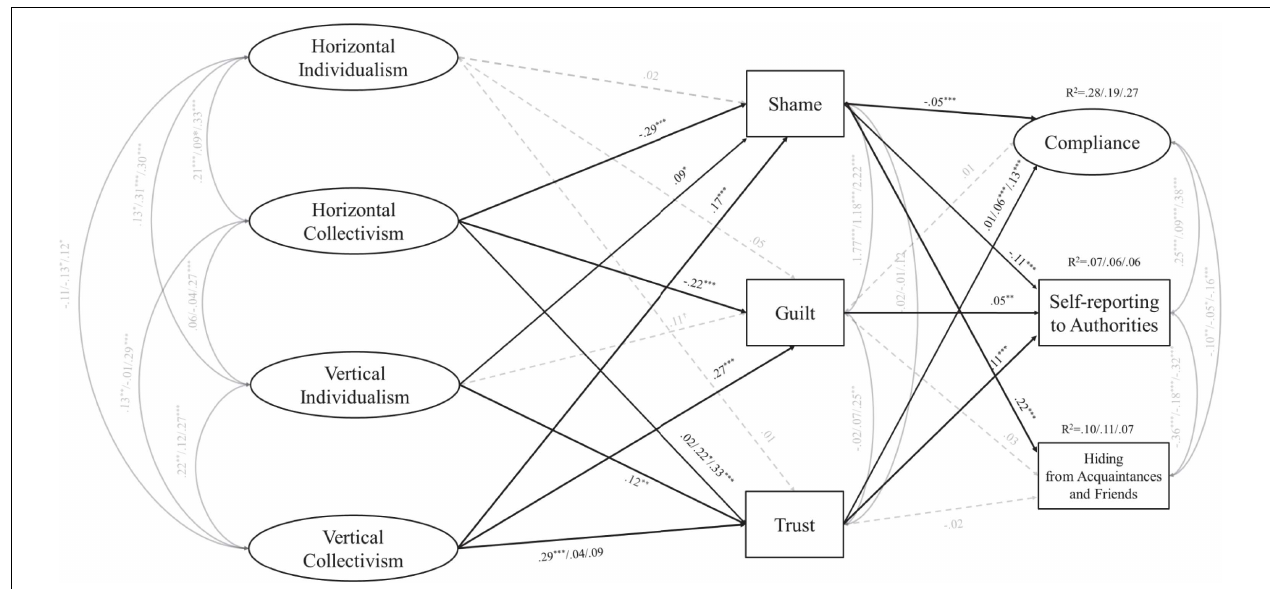
FIGURE 1 | Structural equation model showing unstandardized coefficients. Multiple coefficients indicate an unconstrained path and are reported as USA/IT/KOR. Dashed lines are non-significant paths. Gender, age, perceived concern, and political orientation are covariates in the model. *** p < 0.001, ** p < 0.01, * p < 0.05, ‡ < 0.10. TABLE 3 | Within groups completely standardized solutions for coefficients in the study. United States Italy South Korea United States Italy South Korea